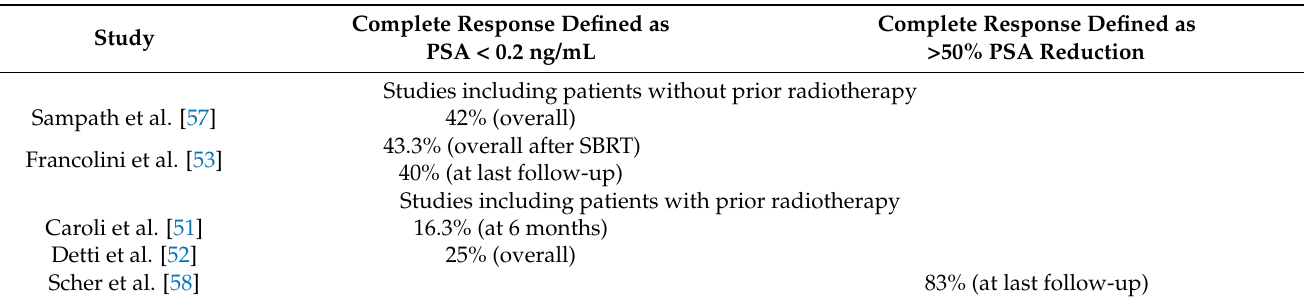
Table 3. Summary of the complete response